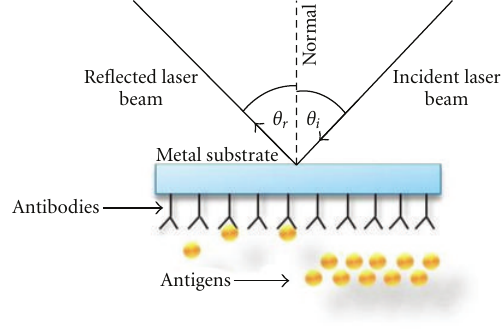
Figure 6: Interaction of biomolecules with